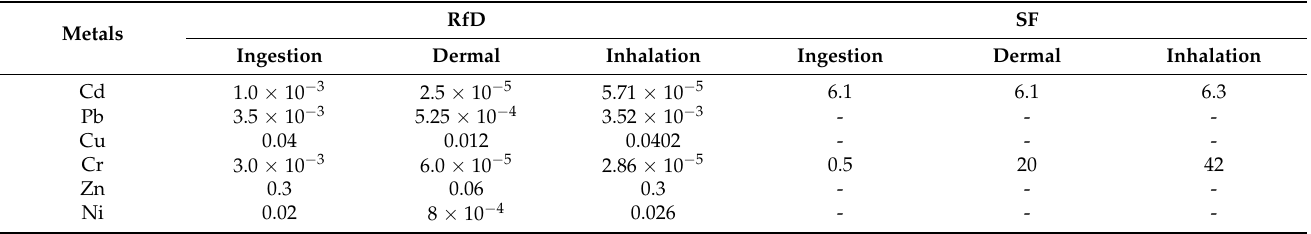
Table 1. Reference values used for calculating the health risk assessment model for each heavy metal.